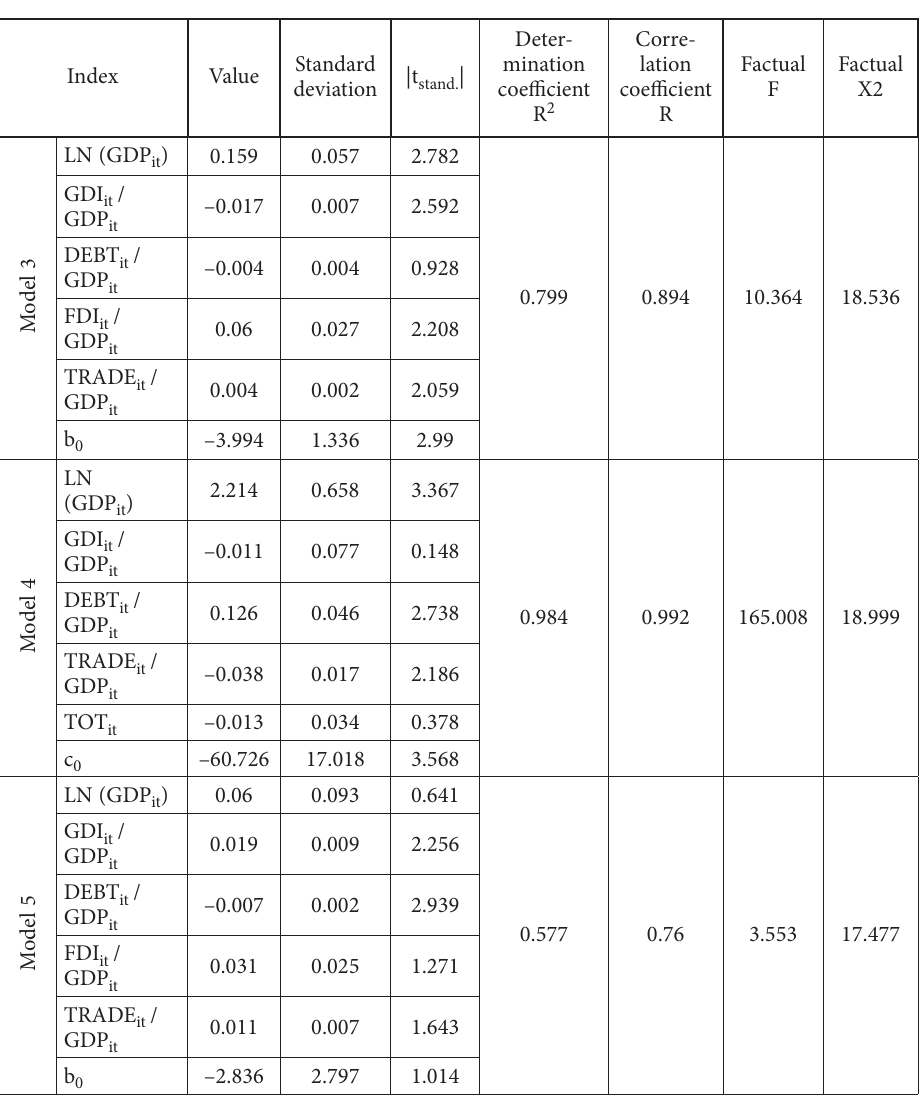
Table 2. Basic initial results of models (3), (4), (5), (6) (source: own